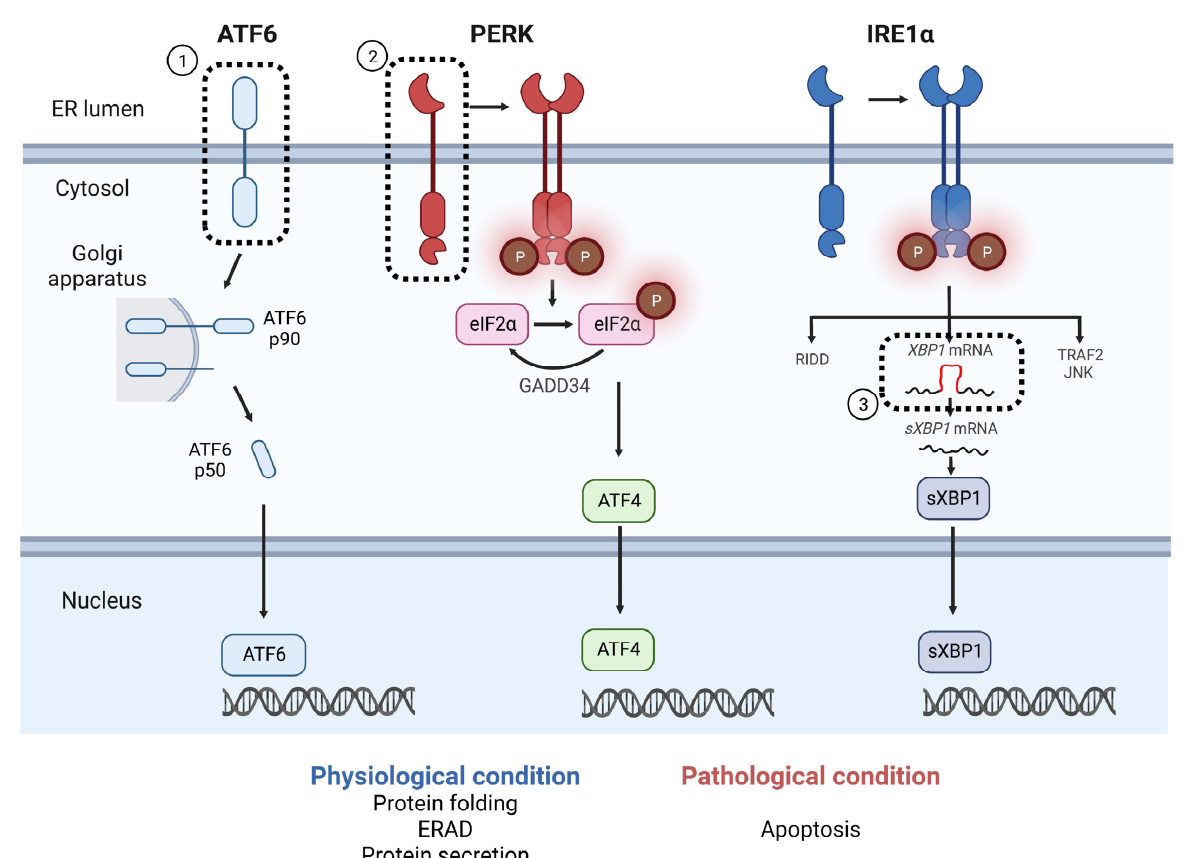
Figure 1. UPR mechanism and the reported SNPs associated with T2DM. The three major regulators (ATF6 α , PERK, and IRE1 α ) are involved in the UPR pathway under pathophysiological conditions. On sensing ER stress, ATF6 α (p90) is cleaved at the Golgi apparatus. Cleaved ATF6 α (p50) translocates to the nucleus and acts as a transcription factor. PERK arrests protein synthesis by phosphorylating eukaryotic translation initiation factor 2 subunit α (eIF2 α ). Phosphorylated eIF2 α also induces the expression of ATF4, which regulates protein synthesis, apoptosis, and autophagy. IRE1 α forms oligomers and autophosphorylates on sensing ER stress, followed by the acquisition of RNase activity. GADD33 dephosphorylates eIF2 α and restores protein synthesis. The activated IRE1 α splices the XBP1 intron and induces the expression of the transcription factor, spliced XBP1 ( sXBP1 ). IRE1 α also suppresses protein folding loads by degrading mRNA, called regulated IRE1-dependent decay (RIDD). In addition, IRE1 α activates the TRAF2/JNK pathway followed by the activation of the autophagy pathway. ① – ③ : The molecules whose SNPs have been reported to contribute to the development of T2DM or insulin resistance include the following. ① ATF6 SNPs, detected in a population of Pima Indians and Dutch Caucasians [12,13]; ② PERK SNPs, detected in Han Chinese populations correlated with increased risk of prediabetes, elevated BMI, and insulin resistance [14]; glucose regulation [14,15]—ATF6 α (or ATF4), activating transcription factor 6 α (or 4); PERK, protein kinase R-like ER kinase; inositol requiring enzyme 1 α (IRE1 α ); ERAD, ER-associated